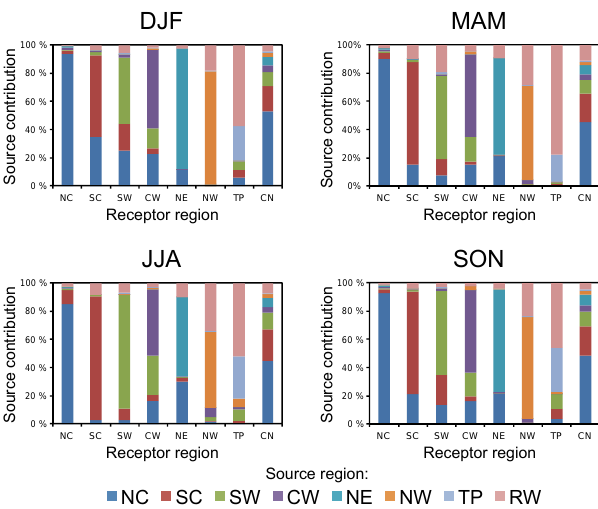
Figure 7. Relative contributions (%) from the tagged source regions (denoted by colors) to regional mean surface concentrations of BC over seven receptor regions in China (NC, SC, SW, CW, NE, NW and TP) and China (seven regions combined, CN) in different sea- sons. The receptor regions are marked on the horizontal axis in each